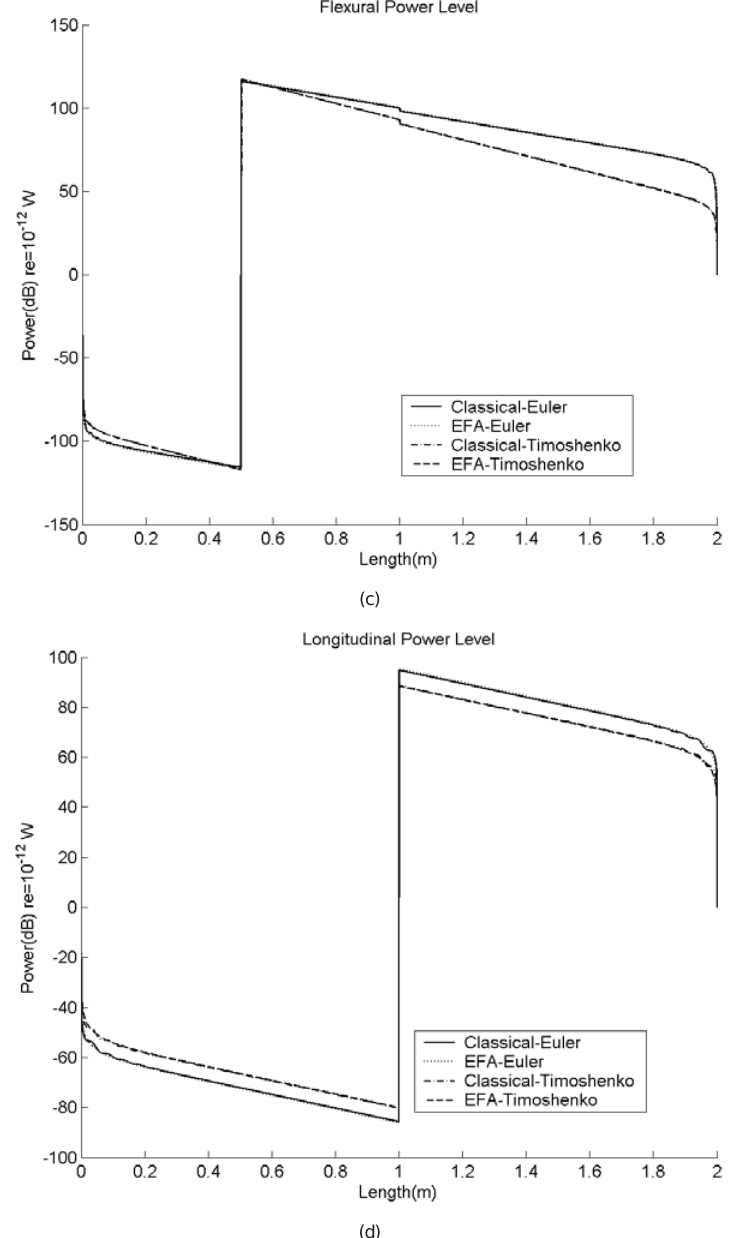
(cid:2) ¯ q (cid:3) | 2 l x 2 = − ( L 1 − x 0 )